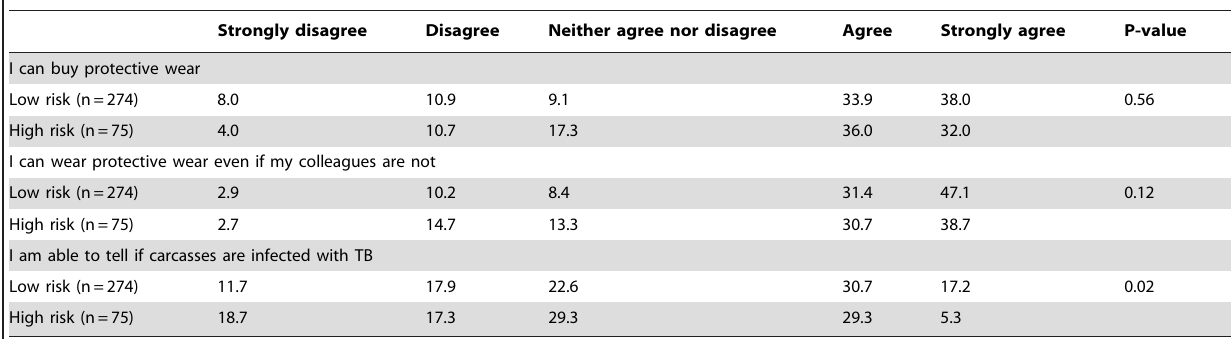
Table 7. Self- efficacy (values are %).